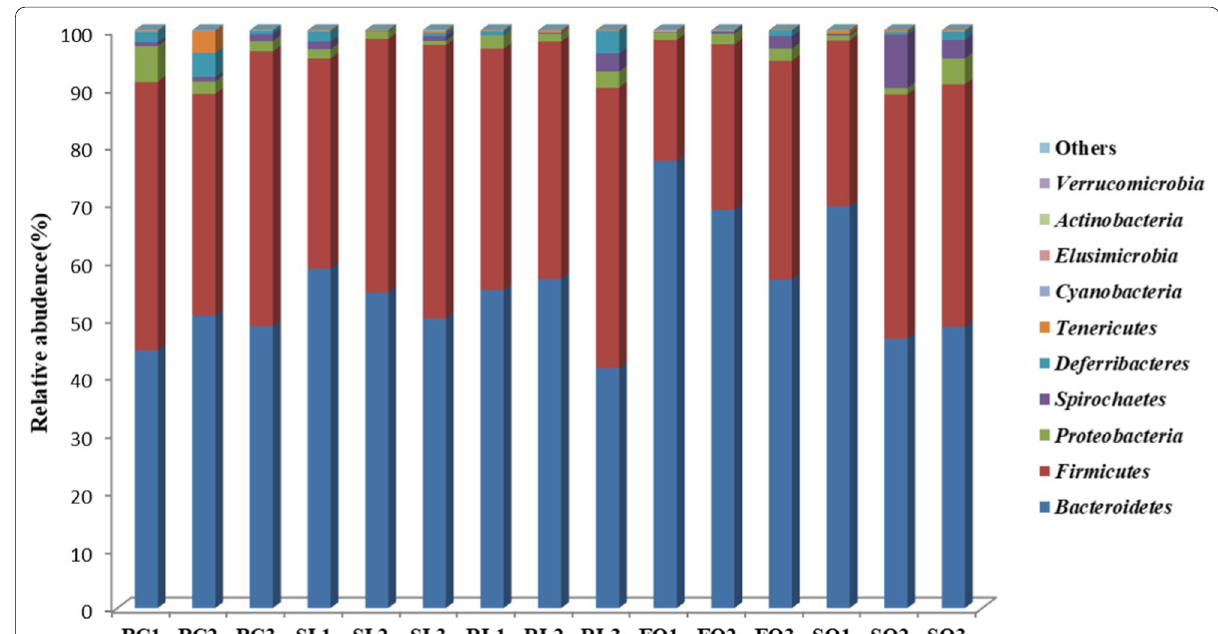
Fig. 3 Effect of stewed lard, refined lard, fish oil and soybean oil on the phylum level of intestinal flora in rats